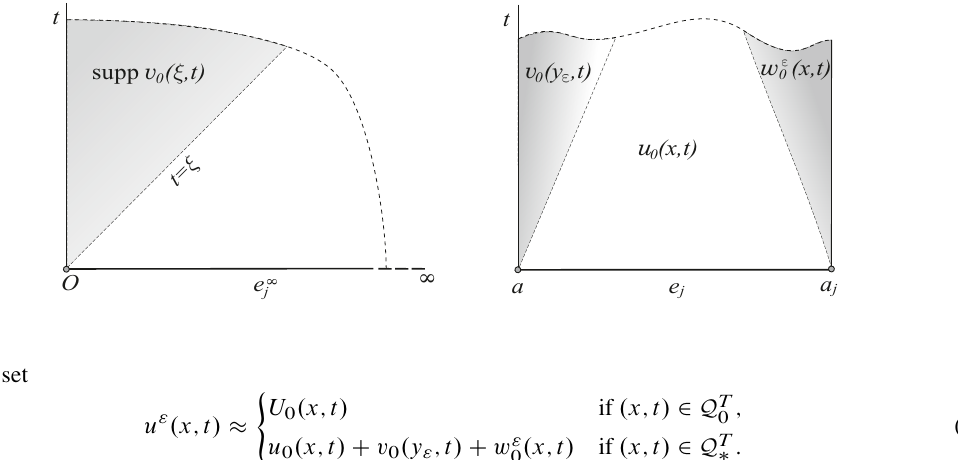
Fig. 3. The boundary layers near the vertices a and a j on the edge e j of subgraph G (cid:3) . The function v 0 is a solution of (27) and w " 0 is defined by (31) , (32)